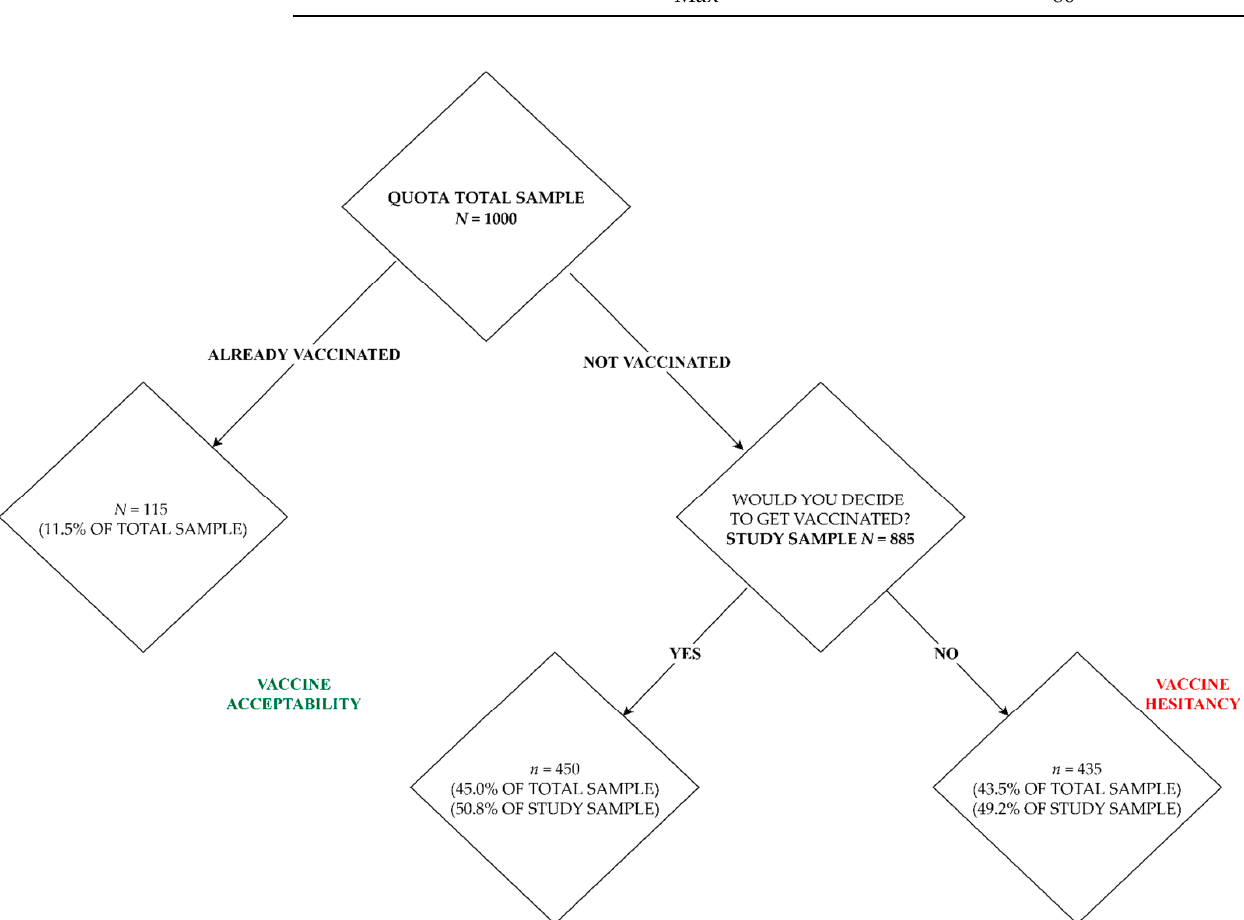
Figure 1. Study sample selection.